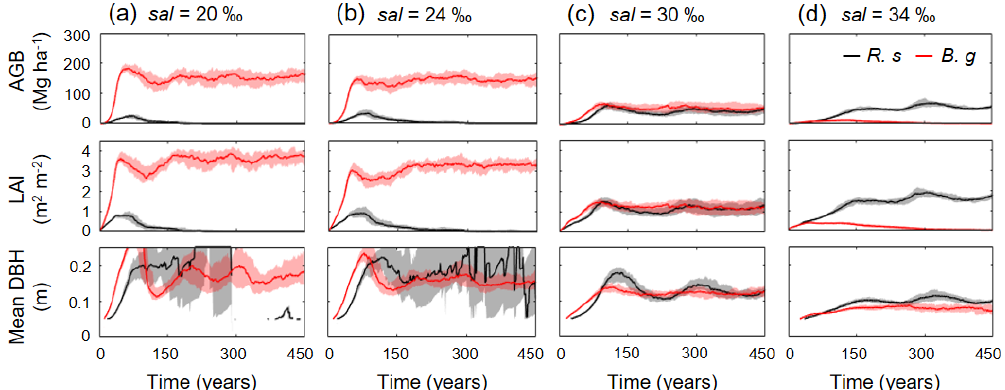
Figure 7. Temporal dynamics in above-ground biomass (AGB), leaf area index (LAI), and mean diameter at breast height (DBH) of R. sty- losa ( R. s ) and B. gymnorrhiza ( B. g ) in four soil salinity conditions: (a) 20‰, (b) 24‰, (c) 30‰, and (d) 34‰. Note that trees with DBH < 0.05m were not included in the calculation of mean DBH. Solid lines show median and shading the 90th percentile from ensemble